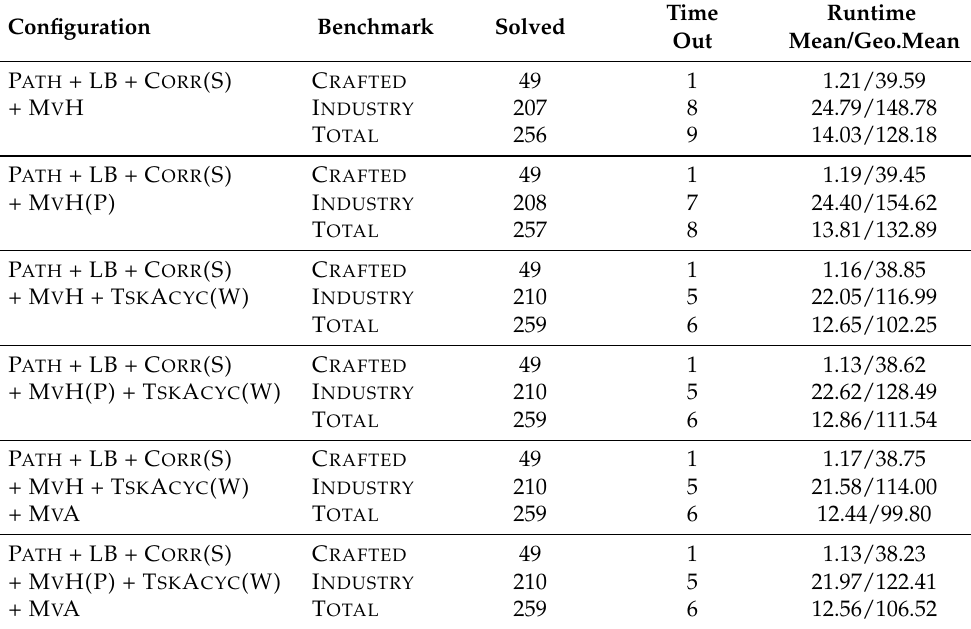
Table 6. Comparison of path encoding configurations for two variants of the move heuristics.